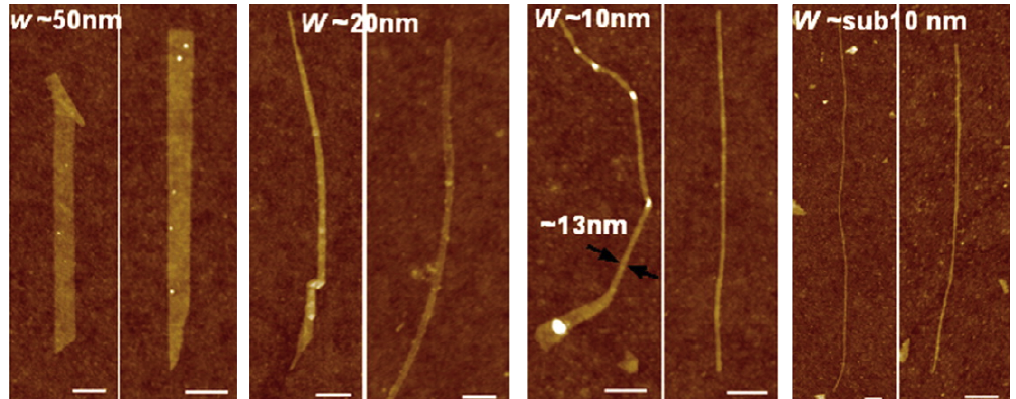
Figure 12. Atomic force microscopy images of selected chemically-derived Graphene Nanoribbons (GNRs) with widths of 50, 30, 20, 10 nm and sub-10-nm, respectively. Scale bar is 100 nm.